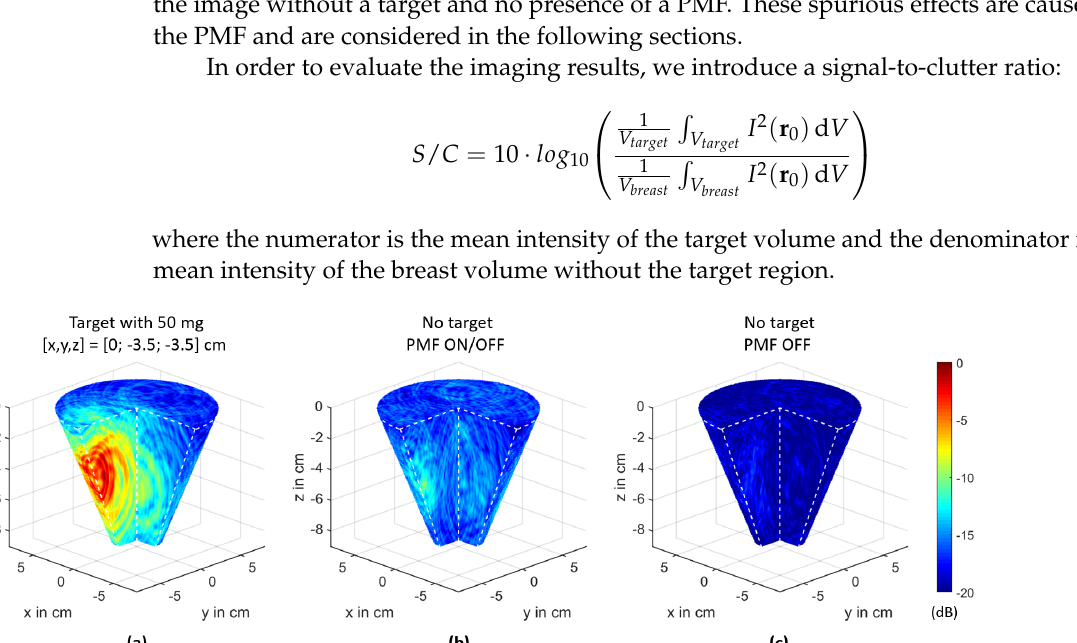
Figure 5. The 3D UWB images based on differential measurements with ∆ y ( t ) = ∆ y DAS input signal: ( a ) I dB ( r 0 ) for the scenario with a 2 mL target with 50mg MNP at the position [ x , y , z ] = [ 0; − 3; − 3.5 ] cm. ( b ) I dB , PMF ( r 0 ) for the scenario without a target and with the presence of a PMF. ( c ) I dB , REF ( r 0 ) for the scenario without a target and no presence of a PMF. The images are normalized to the maximum intensity of Subplot ( a